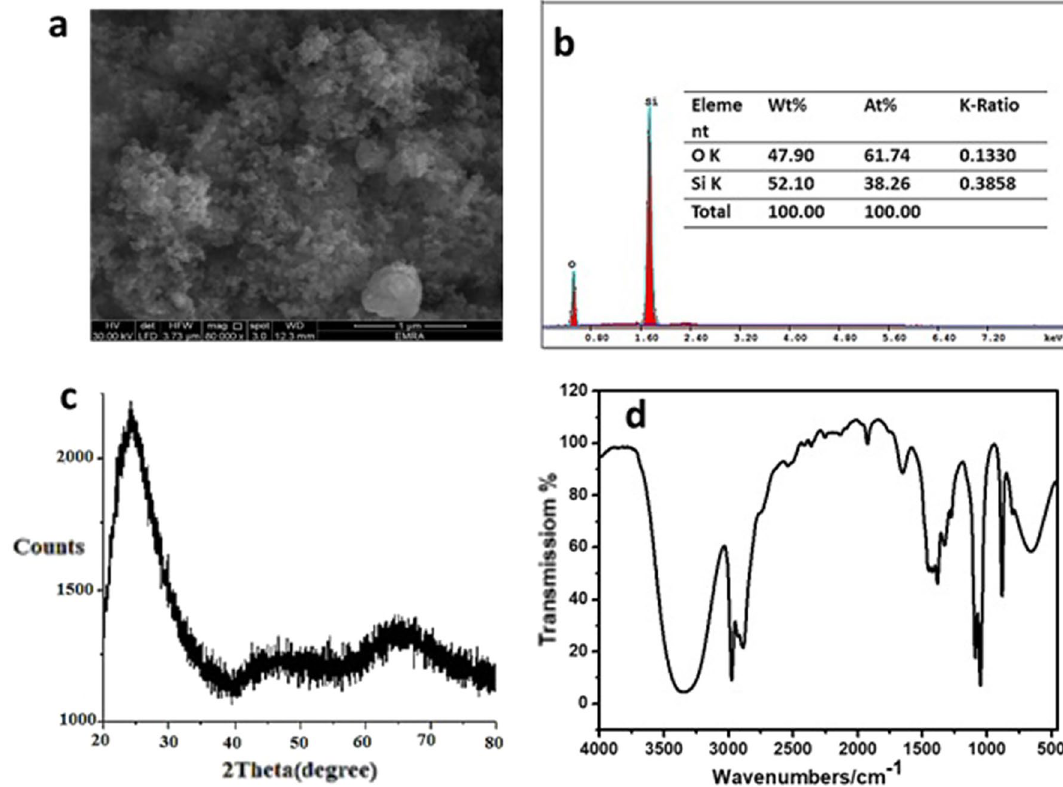
Figure 5. Characterization of the prepared SiO 2 nanoparticles; SEM image ( a ), EDS ( b ), XRD ( c ), and FTIR ( d